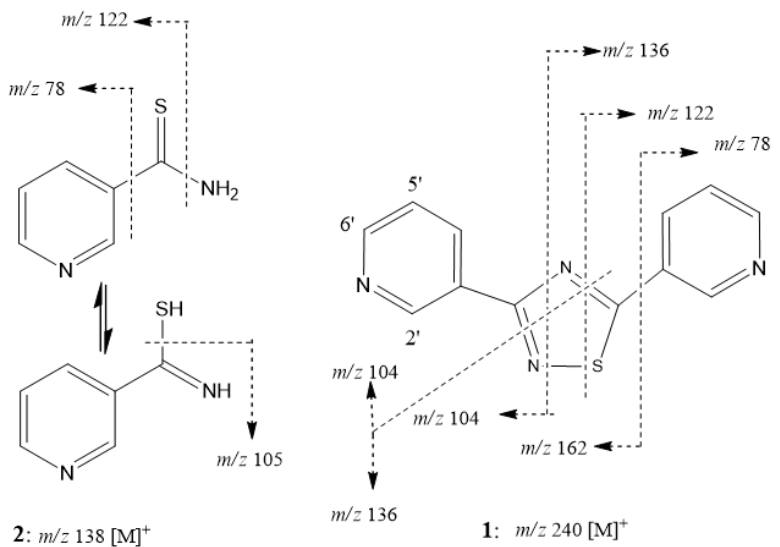
Figure 3. EI ‐ MS fragmentation pattern of 1 and 2 .